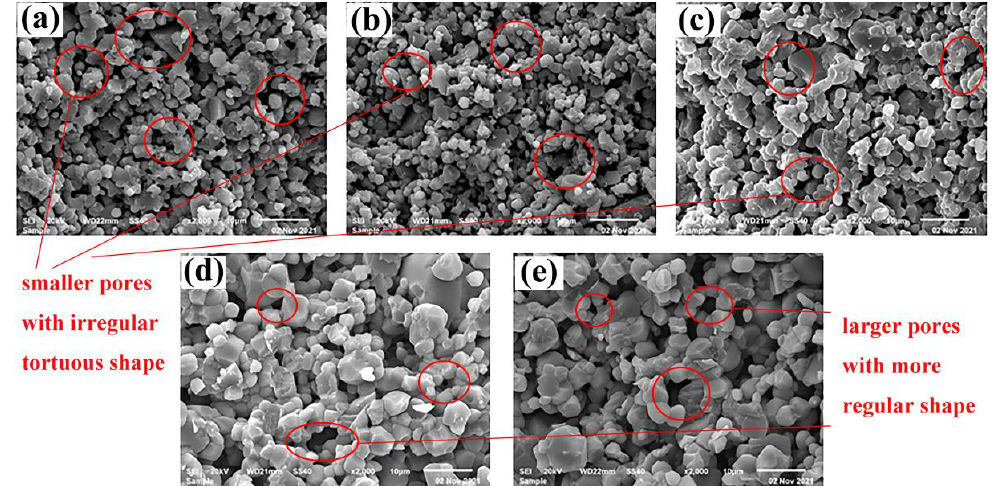
Figure 4. SEM images of the B0.9 samples treated at ( a ) 900 °C, ( b ) 950 °C, ( c ) 1000 °C, ( d ) 1050 °C, and ( e ) 1100 °C.